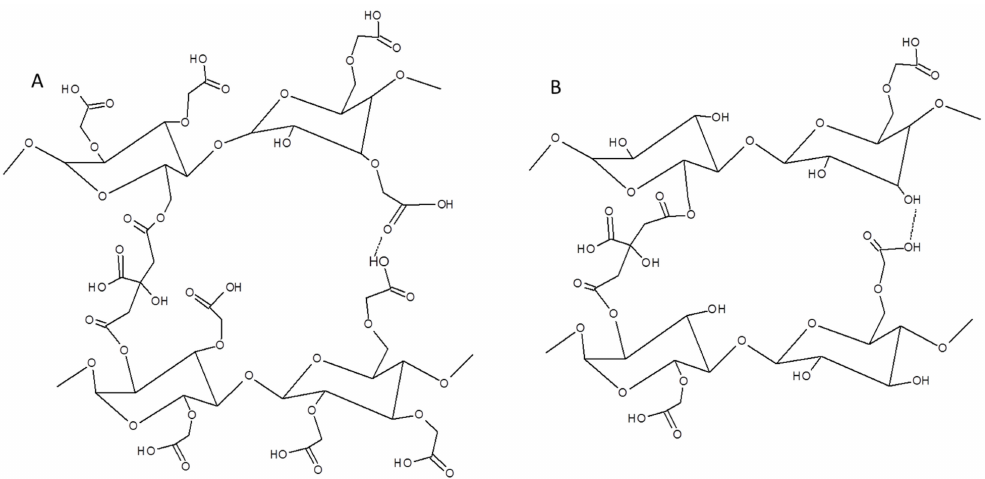
Figure 3. Scheme of interaction between: ( A ) CMC-CMC and ( B ) CMS-CMS molecules.